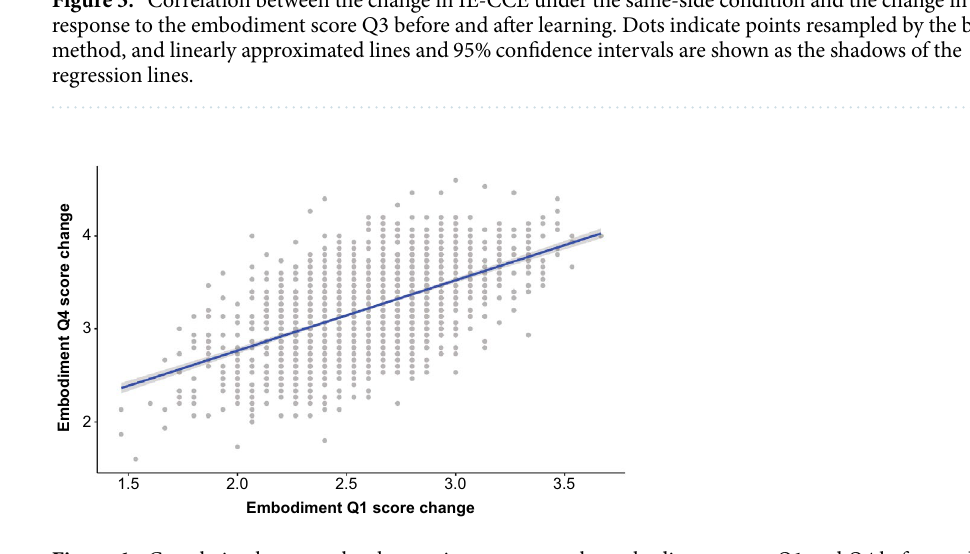
Figure 6. Correlation between the changes in response to the embodiment score Q1 and Q4 before and after learning. Dots indicate points resampled by the bootstrap method, and linearly approximated lines and 95% confidence intervals are shown as shadows of the regression